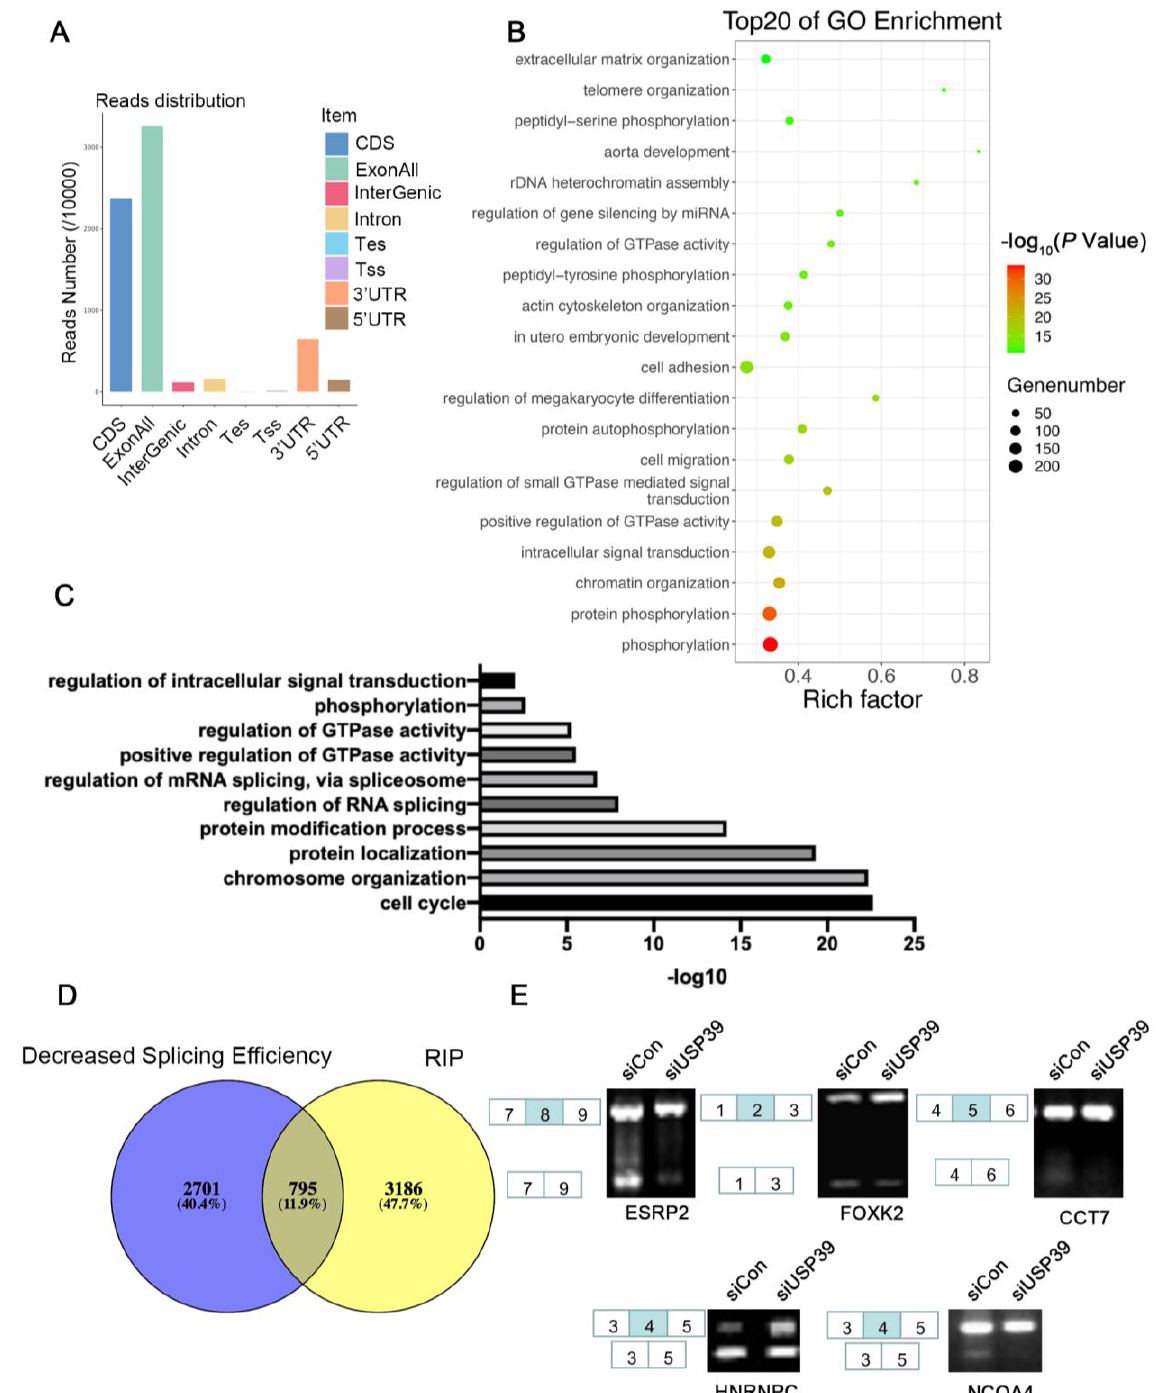
Figure 5. Identification of USP39-regulated splicing events by RNA-seq and RIP-seq. ( A ) Read numbers of USP39 binding peaks based on RIP-seq data. Coding sequence (CDS), transcription start site (Tss), transcription end site (Tes), exon, intron, 3’ untranslated region (3’UTR), and 5’ untranslated region (5’UTR) were extracted by human genome gff3 file from the Ensembl database. ( B ) Bubble diagram showing the results of GO enrichment analysis of genes bound by USP39. ( C ) GO enrichment analysis of genes that presented AS events regulated by USP39. ( D ) The overlap in transcripts identified as being bound by USP39 (from RIP-seq) and different splicing efficiency upon USP39 knockdown (from RNA-seq). ( E ) The AS events regulated by USP39 were detected by RT-PCR. The primer lists are shown in Supplementary Table S1.